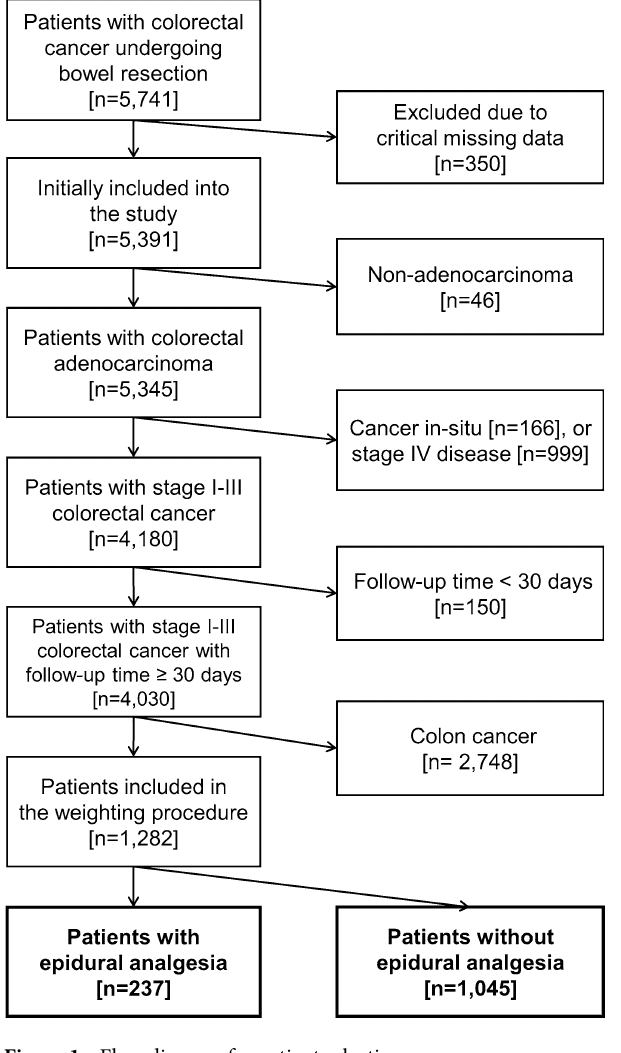
Figure 1. Flow diagram for patient